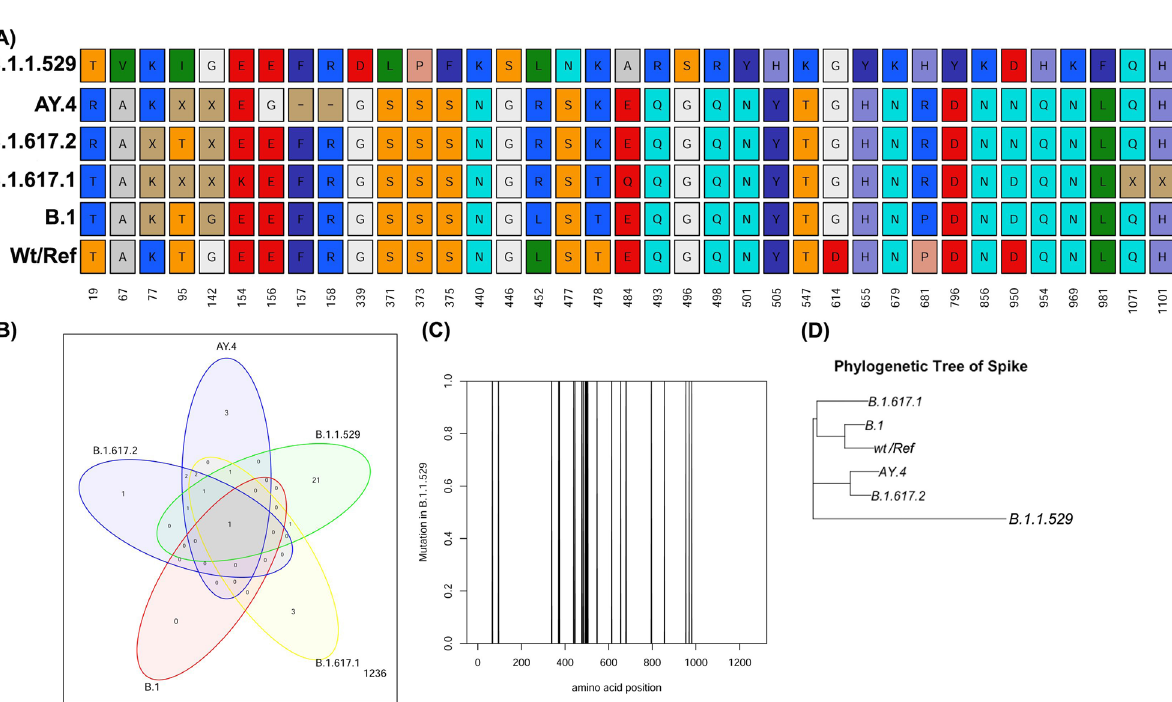
Figure 5. Mutations in various VoC circulating in Indian population in Jan to Sept 2021. ( A ) Mutation in amino acids of various VoCs with respect to wild type/Reference (wt/Ref) S protein is shown along with the position as indicated in number. ( B ) Venn diagram showing overlapping and unique mutations among various VoCs. ( C ) Enriched mutational sites of Omicron (B.1.1.529) lying in the S protein. ( D ) Phylogenetic tree of S protein of various VoCs as